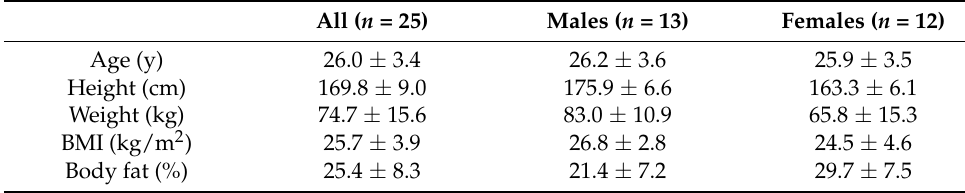
Table 1. Participant Characteristics 1